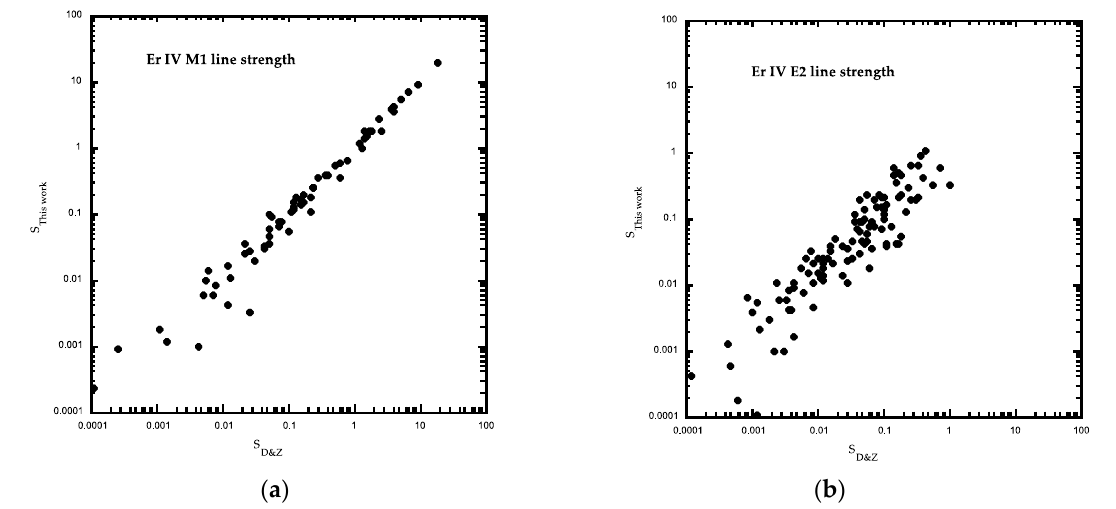
Figure 3. ( a ) Magnetic dipole (M1) and ( b ) electric quadrupole (E2) line strengths in Er IV for the lines between 2000 and 17,000 Å (Cf. Tables 4 and 5).